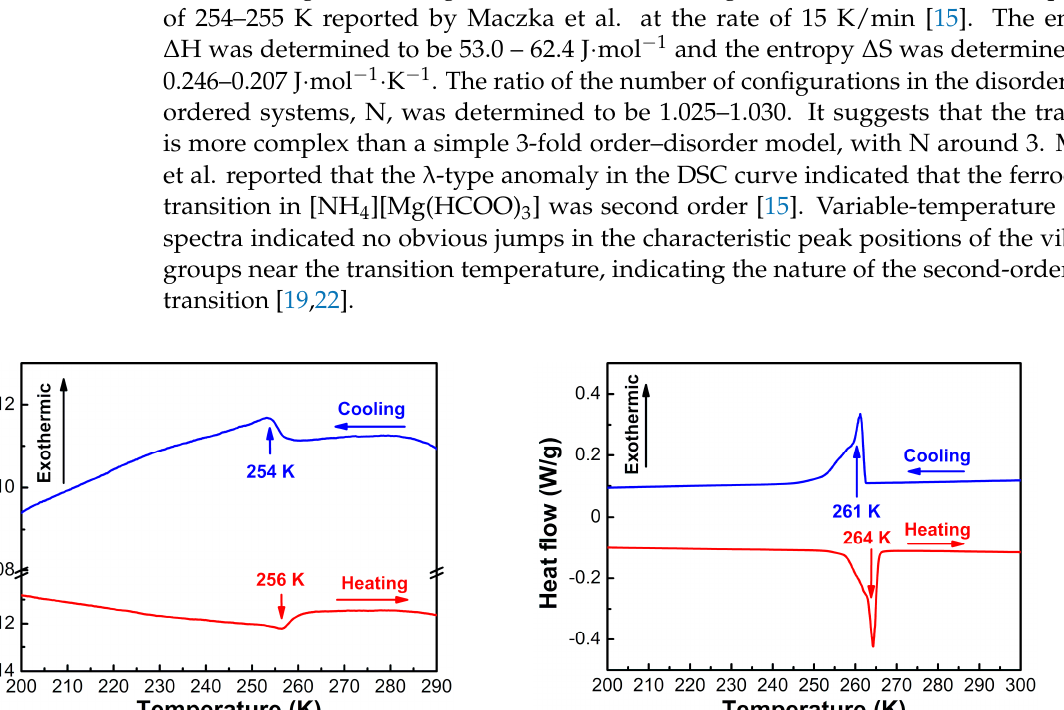
Figure 4. Structures of ( a ) [NH 4 ][Mg(HCOO) 3 ] and ( b ) [(CH 3 ) 2 NH 2 ][Mg(HCOO) 3 ] at room temperature.